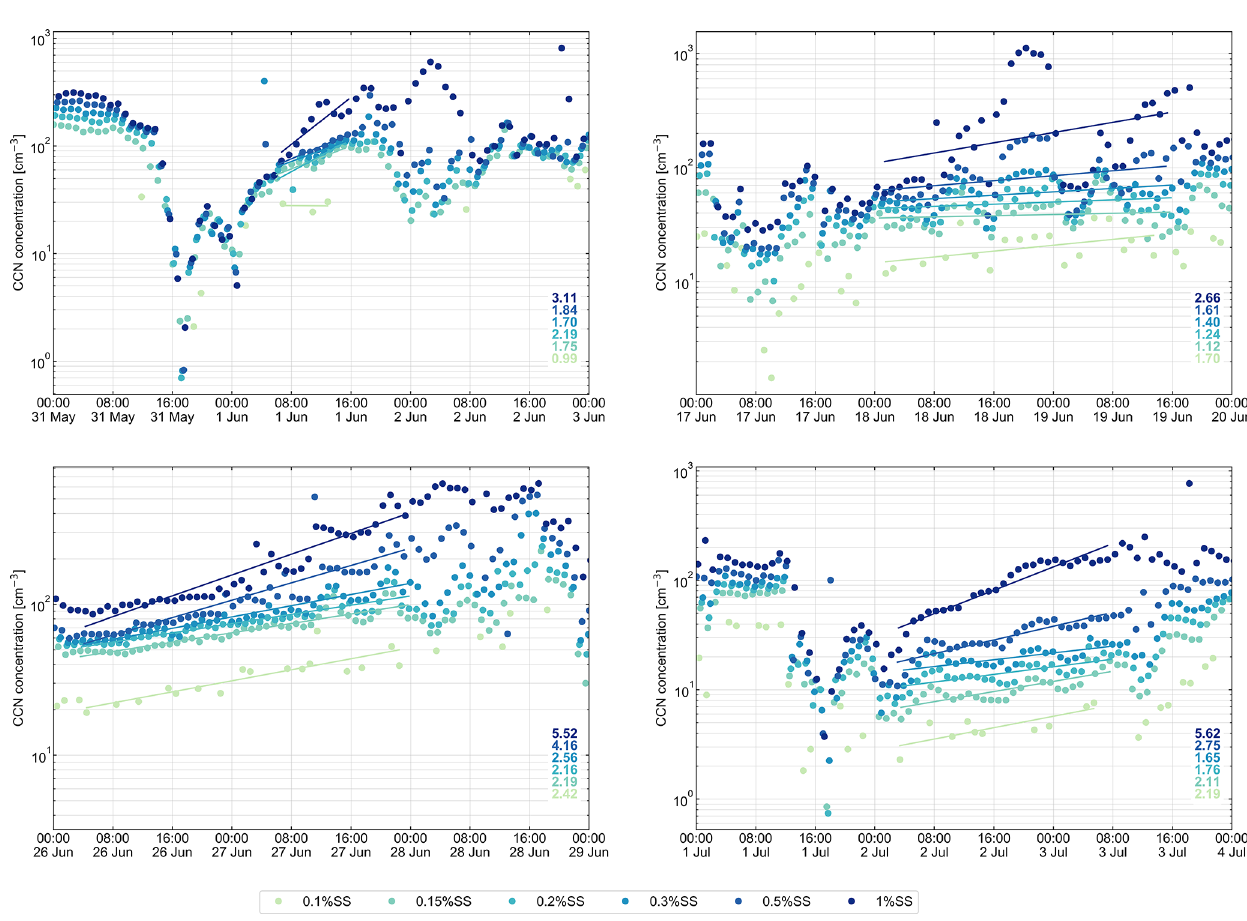
Figure 3. The CCN number concentration measured during NPF events (1 to 4). The lines and corresponding values show the increase in CCN concentrations (prior to NPF versus particles that have grown to the Aitken